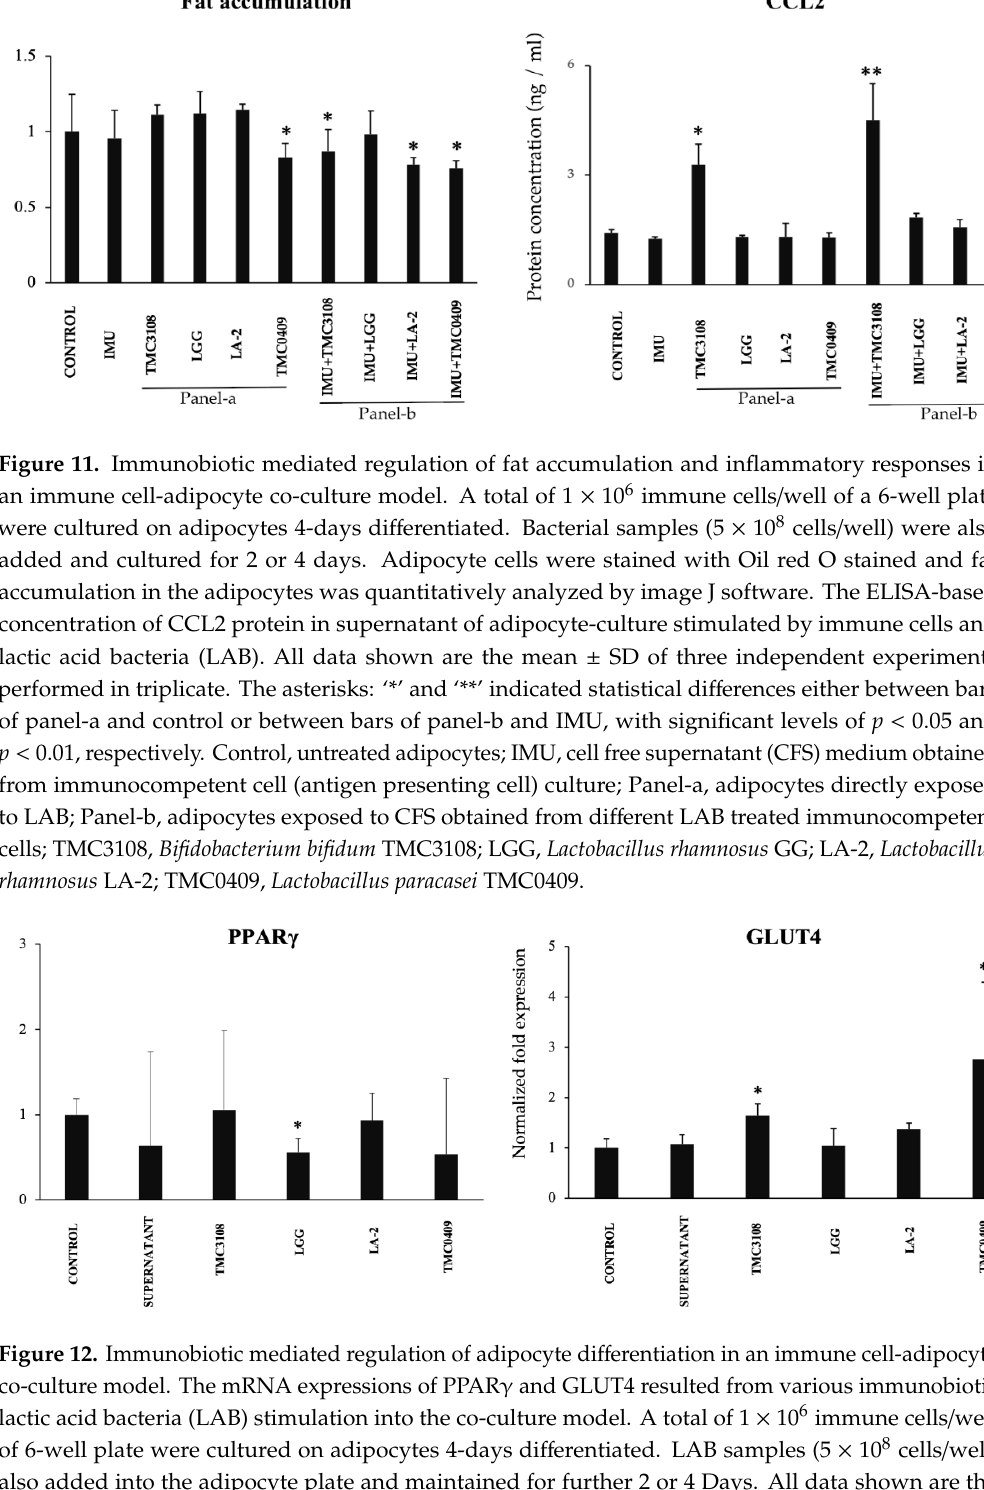
13 of 22 Figure 10. TLR3 mediated adipokine production in adipocytes. The mRNA expressions ( A ) and protein concentration ( B ) of CCL2, IL-6, IL-8, IL-10 in the adipocytes at different time points of 20 days of differentiation. Data shown are the mean ±SD of 3 independent experiments performed in triplicates. The ‘*’ indicated statistical differences when compared with day 0, and ‘†’ indicated statistical differences when compared with the control group at the same time point, both at the significance level of p < 0.05. 3.10. Immunobiotic Mediated Regulation of Fat Accumulation and Adipokine Production in Adipocytes during LTAD Previously, we demonstrated that some immunobiotic strains are able to differentially modulate fat accumulation and proinflammatory mediators’ expression during short term adipogenic differentiation of PIP cells [16]. Then, we aimed to evaluate whether the same lactobacilli and bifidobacteria strains were able to modulate fat accumulation and CCL2 expression during LTAD. For this purpose, two sets of experiments were performed. First, porcine adipocytes were treated directly with bacterial strains. As shown in Figure 11 (Panel-a) no effect on fat accumulation was observed for the evaluated strains with the exception of L. paracasei TCM0409, which significantly reduced this parameter. In addition, only B. bifidum TCM3108 induced a significant up-regulation of CCL2 expression. In a second set of experiments, we performed several in vitro steps to simulate